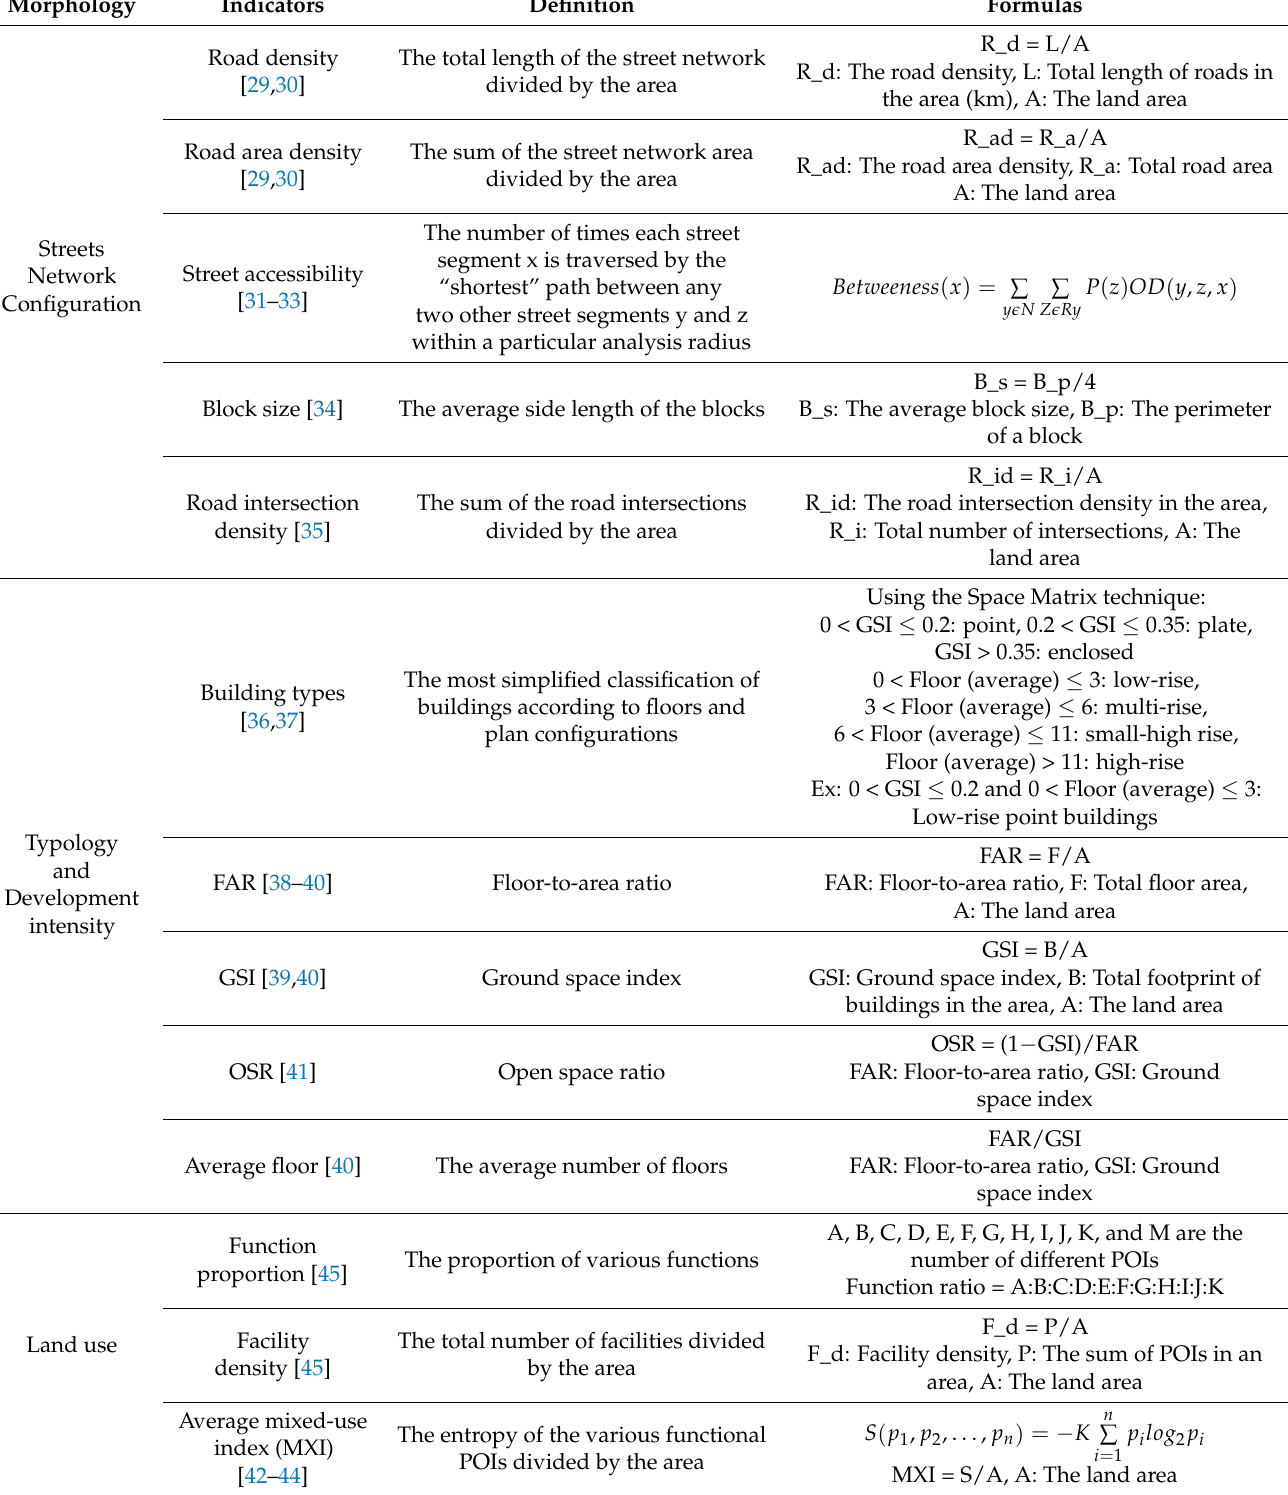
Table 1. The morphological